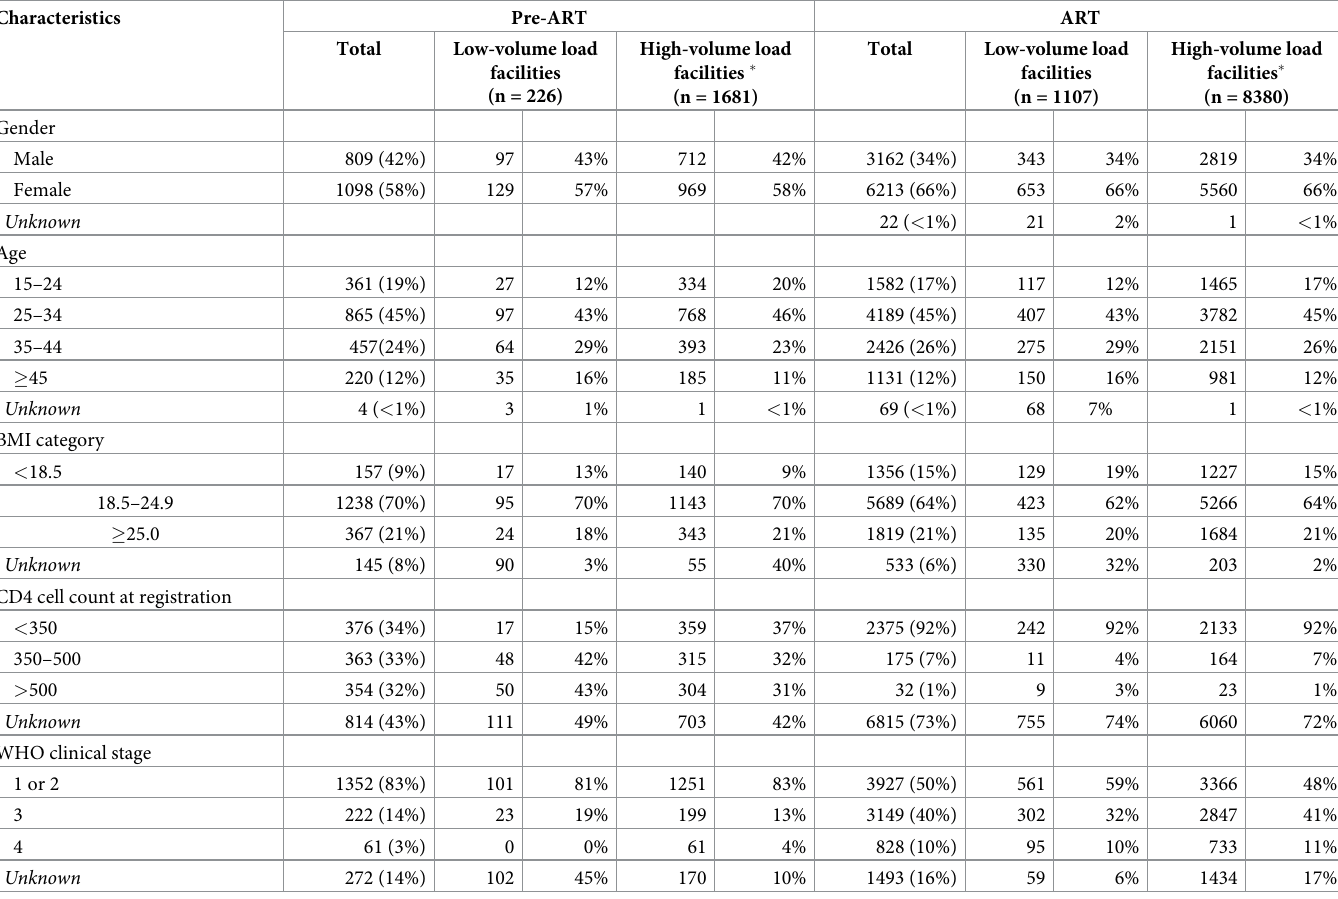
Table 1. Baseline characteristics of HIV-infected persons who registered for pre-ART and ART care between April 2012 and March 2013 in Lilongwe, Malawi.